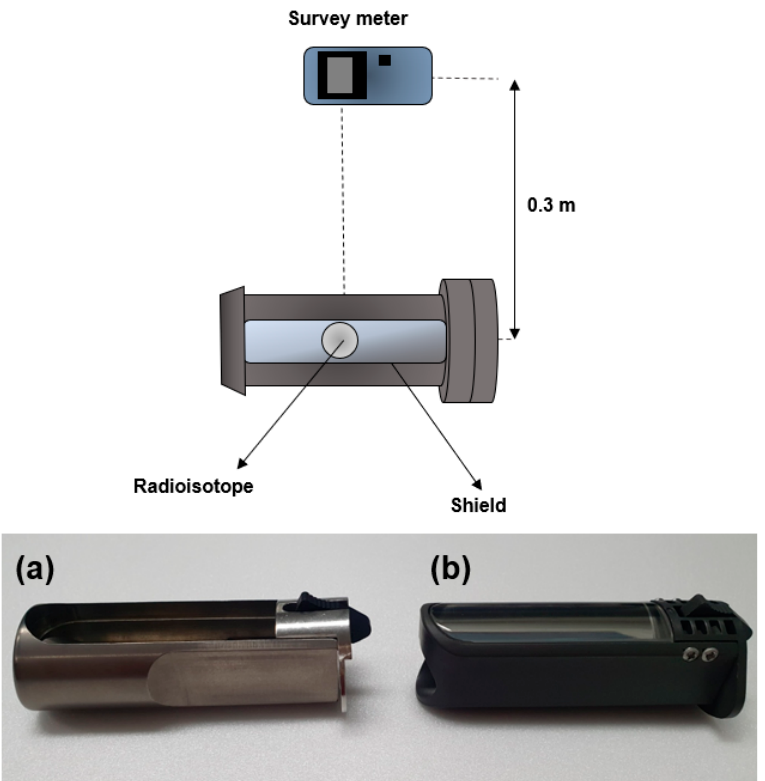
Figure 3. Appearance and measurement method of the manufactured radiation syringe shield: ( a ) existing lead syringe shield and ( b ) plastic syringe shield.